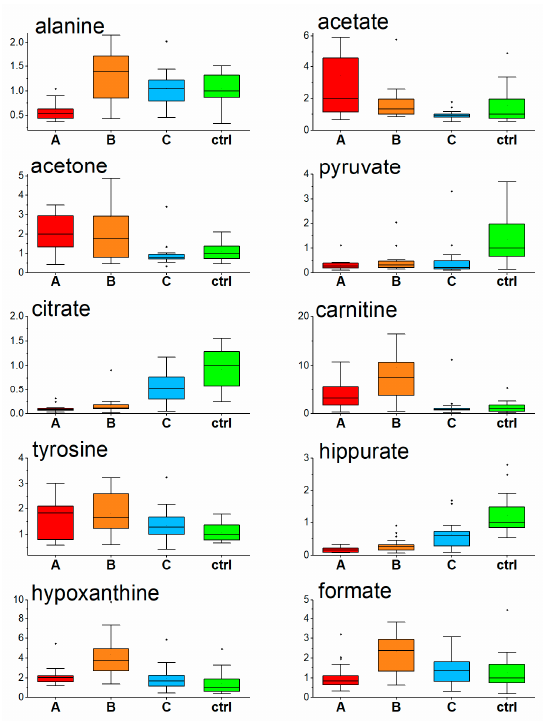
Figure 3. Relative levels of urine metabolites in COVID-19 patients at three consecutive timepoints and controls, data normalized to the level of creatinine, values related to the median of controls set to 1. (A ‐ Day 1; B ‐ Day 5–8; C ‐ Day 29–54, ctrl ‐ controls).